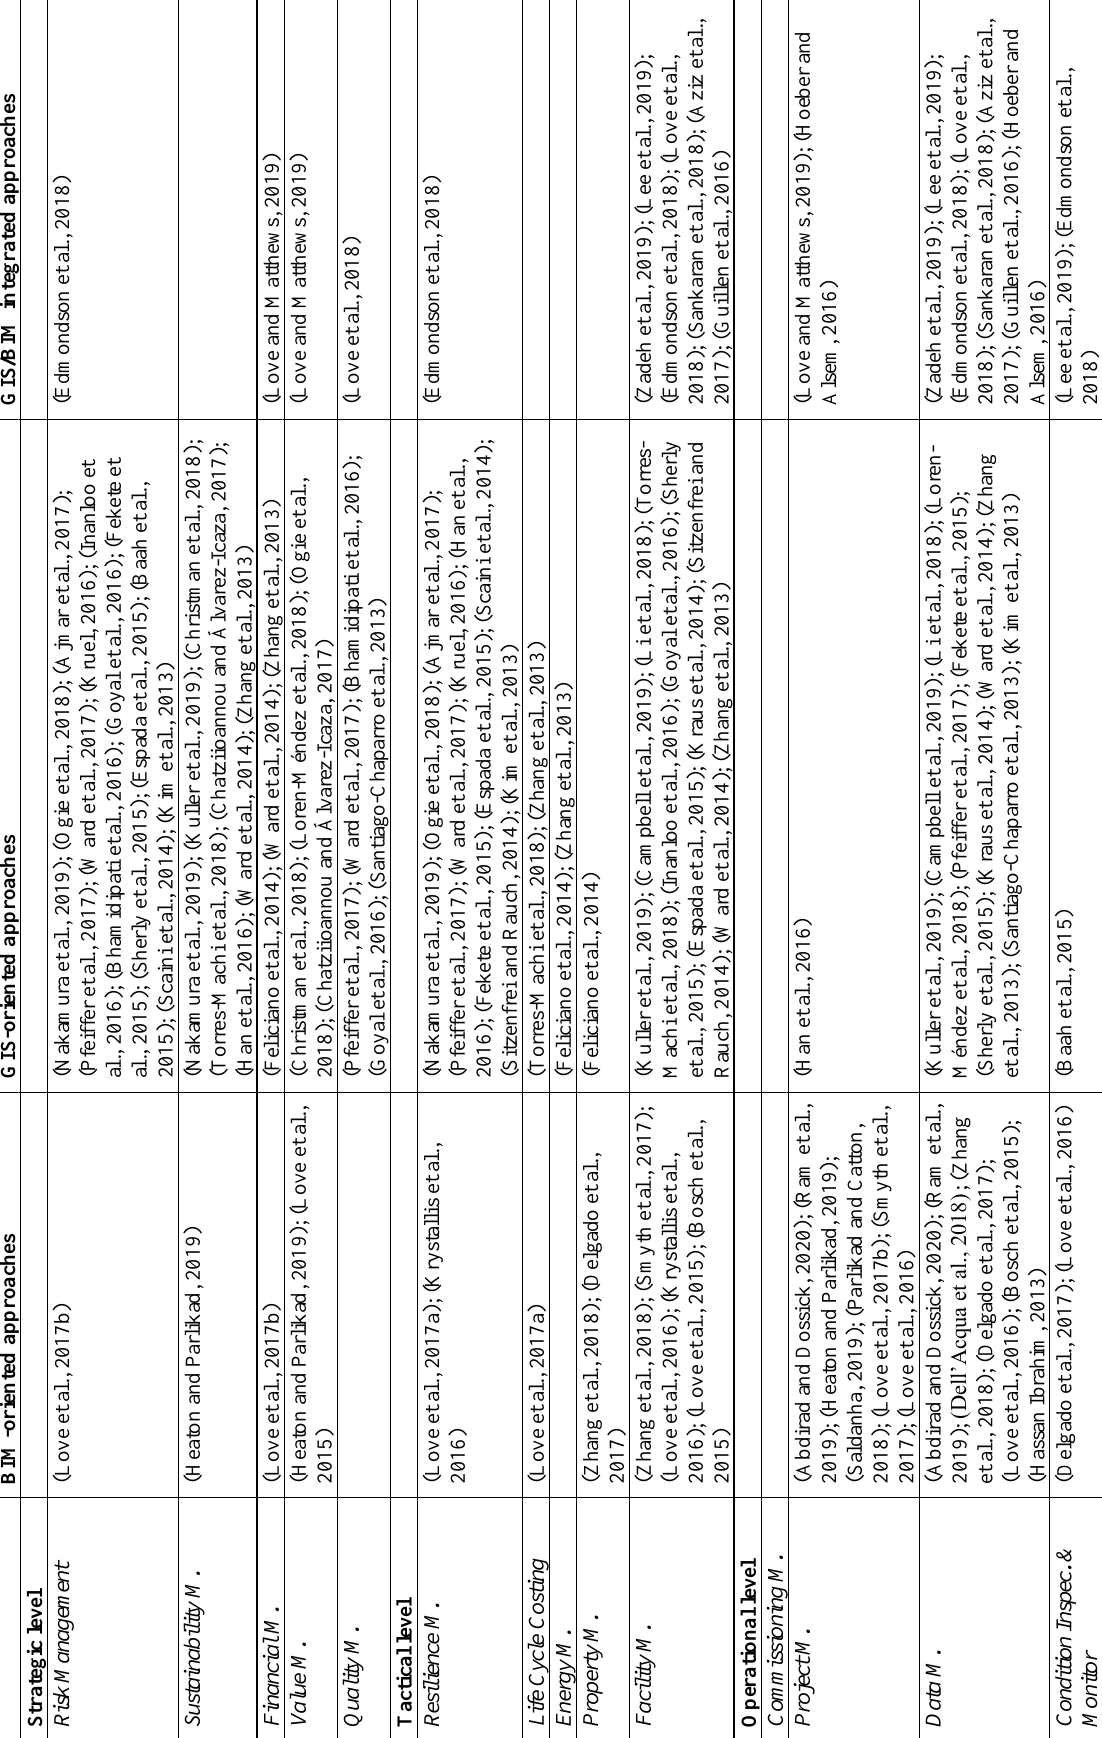
Table 1. Articles organised by type of approach implemented by the authors and Asset Management